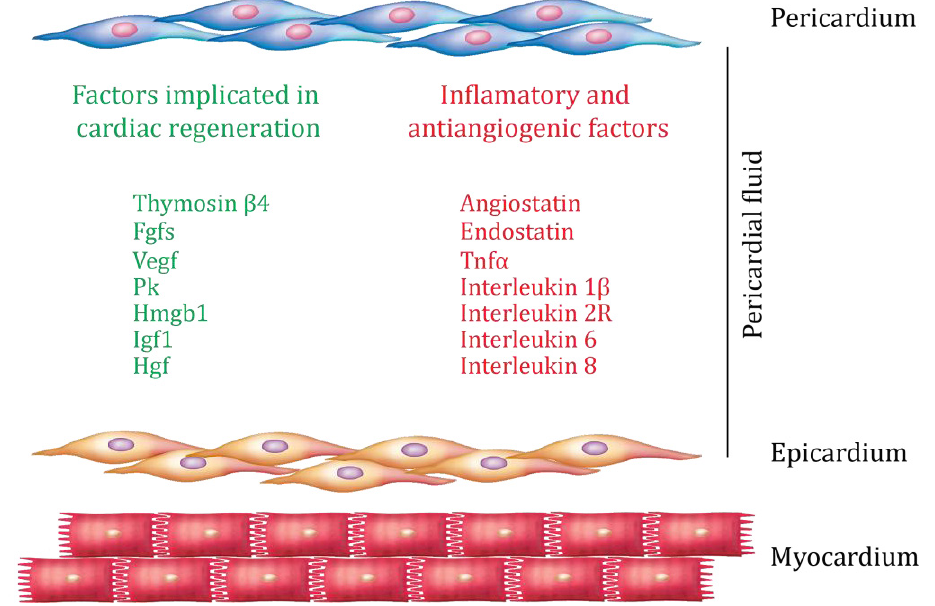
Figure 4. Regenerative and inflammatory response after myocardial injury. Factors accumulate in the pericardial fluid after myocardial infarction that may affect both epicardial and myocardial function and which are implicated in cardiac regeneration and inflammation. Recent studies suggest that the balance between regenerative and inflammatory factors can affect repair and subsequent cardiac